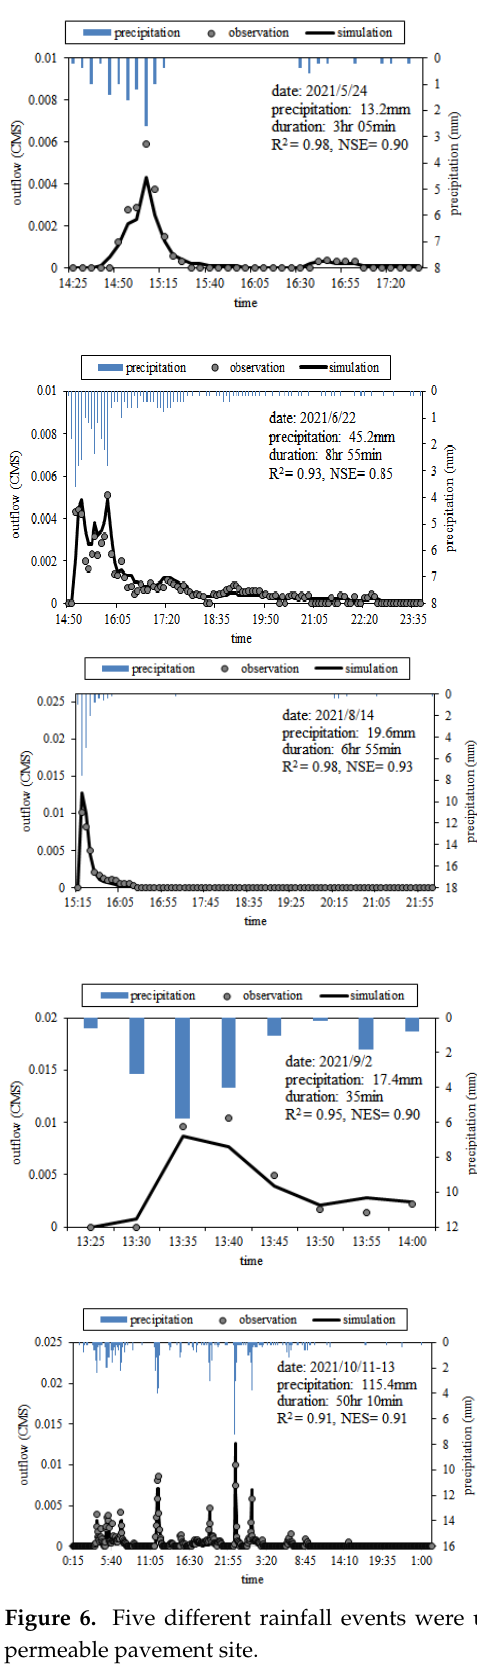
Figure 6. Five different rainfall events were used for model calibration and verification at the permeable pavement site.